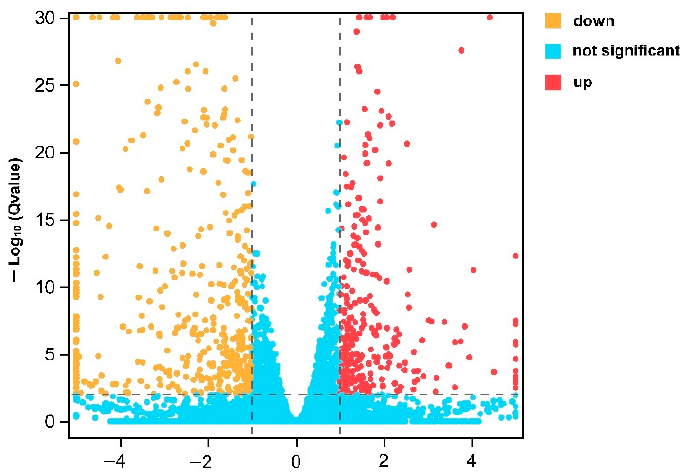
Figure 2. Volcanic map of DEGs in LW-13 compared with